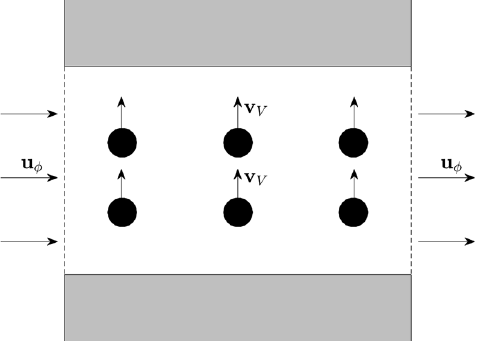
FIG. 1. Dissipative vortex motions in superfluid channel flow according to the Josephson-Anderson relation. Solid black dots denote quantized vortices pointing into the plane and moving across flow lines of the background superfluid velocity u ϕ with a transverse vortex velocity v , which may arise either from vortex- V induced motions or from nonideal effects. When a single vortex crosses the entire channel width, the superfluid phase difference Δ θ between outflow and inflow points changes by 2 π , a so-called 2 π phase-slip